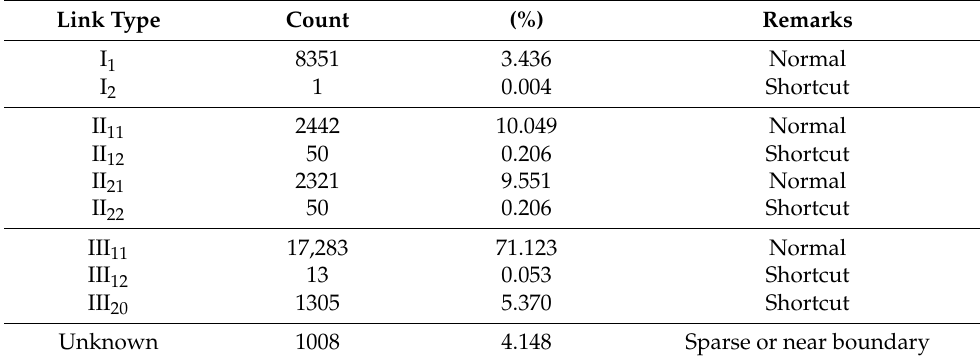
Table 2. Tracking link statistics for